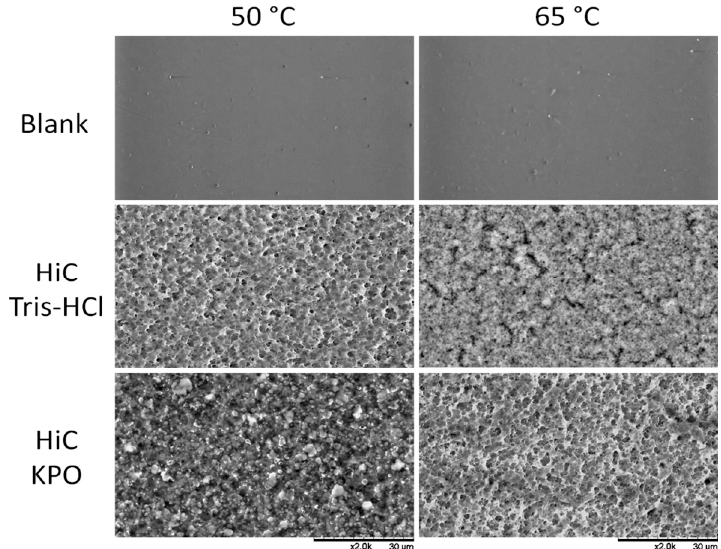
Figure 5. Scanning Electron Microscopy (SEM) pictures of amorphous PEF films after 48 h enzymatic hydrolysis with HiC in 0.1 M Tris-HCl pH 7 (middle) and 1 M KPO pH 8 (bottom). Left side shows films with 50 °C, right side shows films with 65 °C reaction temperature. The upper pictures show the control reactions.